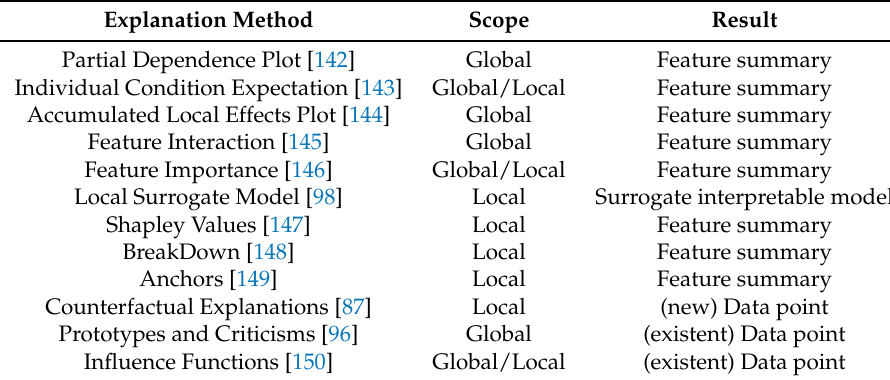
Table 4. Model-agnostic explanation methods